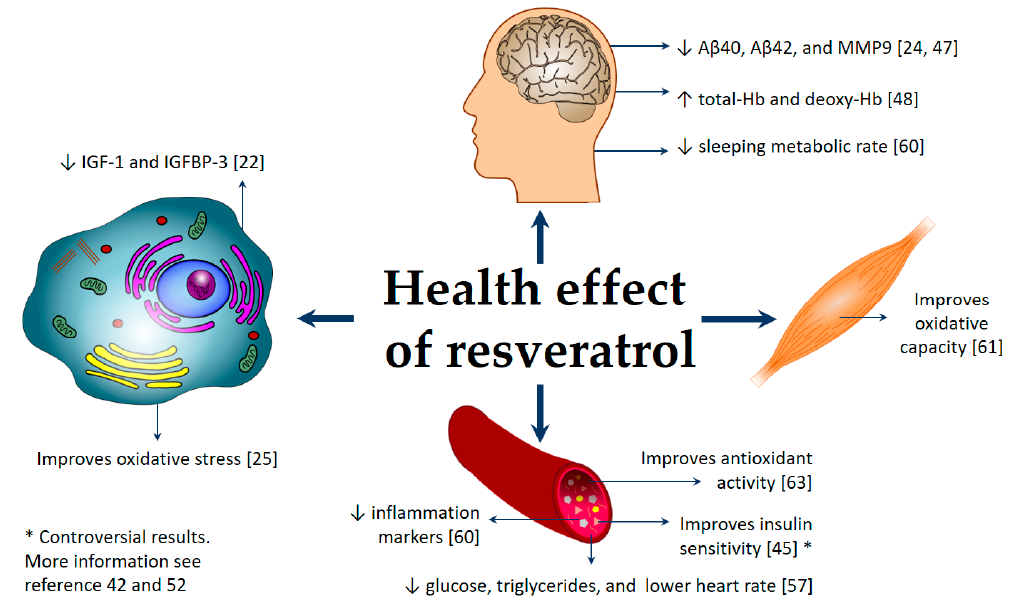
Figure 2. Health effects of resveratrol. A summary of the results of different studies reporting a positive effect of RV on health.